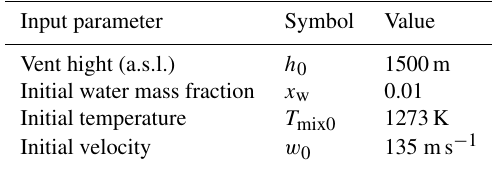
Table 3. Relevant input parameters of the plume model fixed for all the simulations of the sensitivity